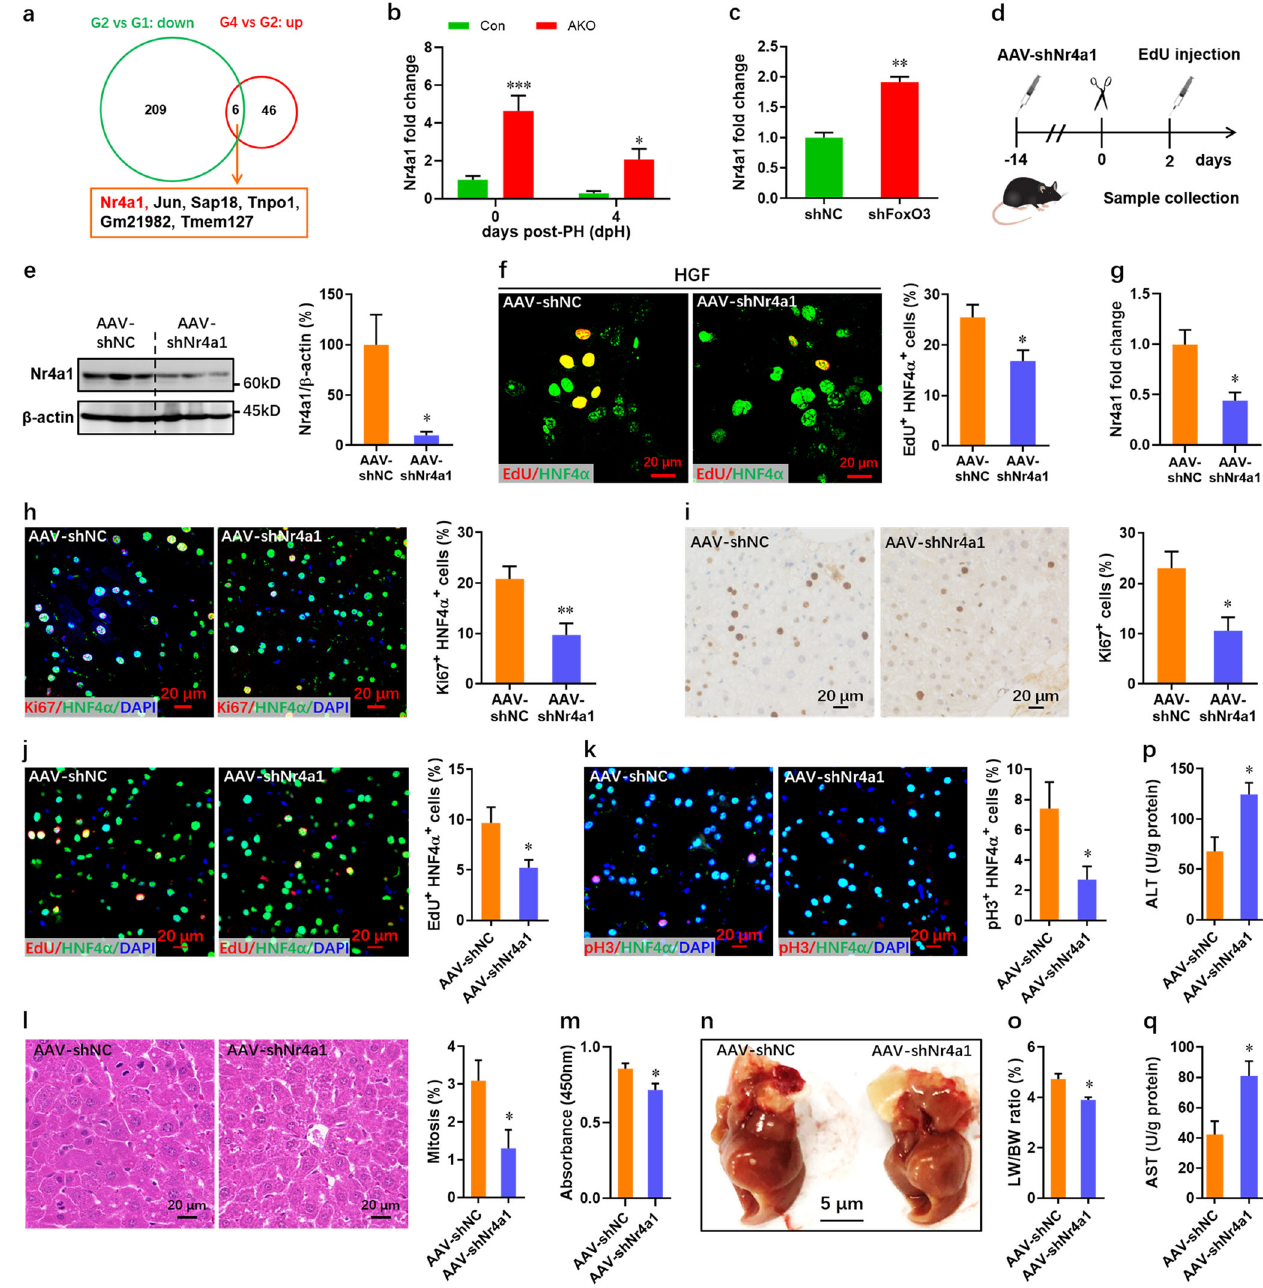
Fig. 7 Knockdown of Nr4a1 inhibits the proliferation of FoxO3-de fi cient hepatocytes. a RNA-seq identi fi ed six overlapping genes between the downregulated gene sets in control mice post-PH (G2) versus pre-PH (G1) and upregulated gene sets in AKO mice (G4) versus control mice post-PH (G2). G1, control mice pre-PH; G2, control mice post-PH; G4, mutant mice post-PH. b qPCR validation of Nr4a1 expression in AKO mice before and after PH ( n = 6 mice per group). c Upregulation of Nr4a1 expression in FoxO3 -de fi cient NCTC1469 cells ( n = 3 per group). d Schematic of AAV-shNr4a1 injection in adult AKO mice for 2 weeks, followed by primary hepatocytes isolation at 0 dpH or PH performance and EdU injection at 2 dpH. e , f Isolated primary hepatocytes at 0 dpH were treated with HGF (40 ng/ml) for 4 days in MHGM, followed by Western blotting assay (e, n = 6 per group) and EdU/HNF4 α double staining ( f , n = 6 per group). g qPCR validation of Nr4a1 expression in livers at 2 dpH ( n = 4 mice). h Representative images (left) and quanti fi cation (right) of Ki67 + HNF4 α + cells in liver at 2 dpH ( n = 6 mice per group). i Representative images (left) and quanti fi cation (right) of Ki67 + cells in liver at 2 dpH ( n = 6 mice per group). j Representative images (left) and quanti fi cation (right) of EdU + HNF4 α + cells in AAV-shNC and AAV-shNr4a1 mice at 2 dpH ( n = 6 mice per group). k Representative images (left) and quanti fi cation (right) of pH3 + HNF4 α + cells in livers at 2 dpH ( n = 6 mice per group). l Representative images (left) and quanti fi cation (right) of mitotic hepatocytes in livers at 2 dpH ( n = 6 mice per group). m Cell counting assay for primary hepatocytes isolated from livers at 2 dpH ( n = 6 mice per group). n Representative images of livers at 2 dpH. o The actual ratio of liver/body weight at 2 dpH ( n = 6 mice per group). p , q Liver ALT ( p ) and AST ( q ) levels in AKO mice injected with AAV-shNC and AAV-shNr4a1 at 2 dpH ( n = 3 mice per group). All data are presented as the mean ± SEM. * p < 0.05, ** p < 0.01, *** p < 0.001 versus controls (two-way ANOVA test for b ; Student ’ s t -test for c , e – q